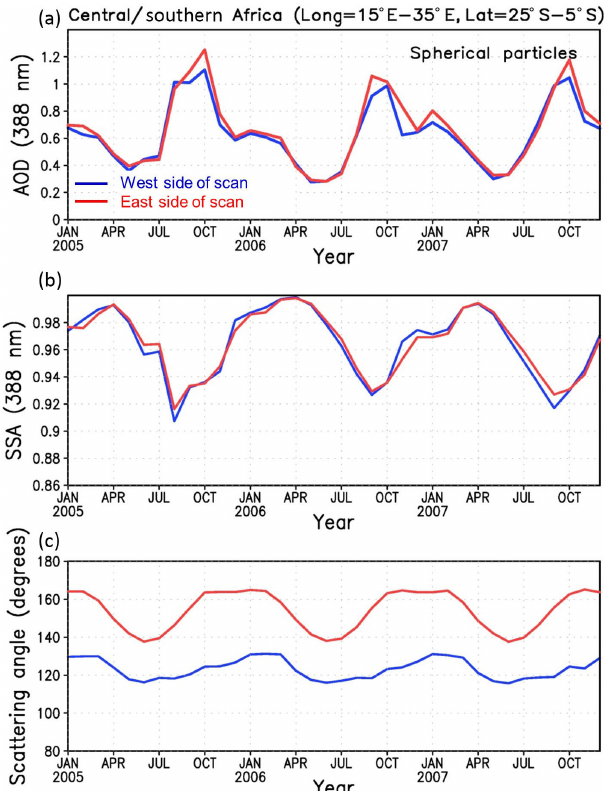
Figure 2. Time series of monthly averages of OMI retrieved AOD (a) and SSA (b) over Southern Africa. The red line repre- sents the average calculated from observations by rows 1 through 30, whereas the blue line indicates the resulting averages when us- ing rows 31 through 60. The bottom panel shows the average scat- tering angle for the two data subsets. See text for